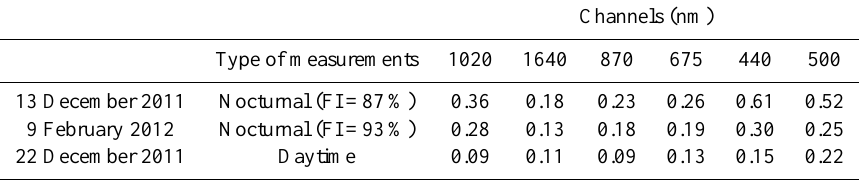
Table 1. CE-318U triplets in % obtained for two nights with different moon’s fraction of illumination (FI) and for daytime